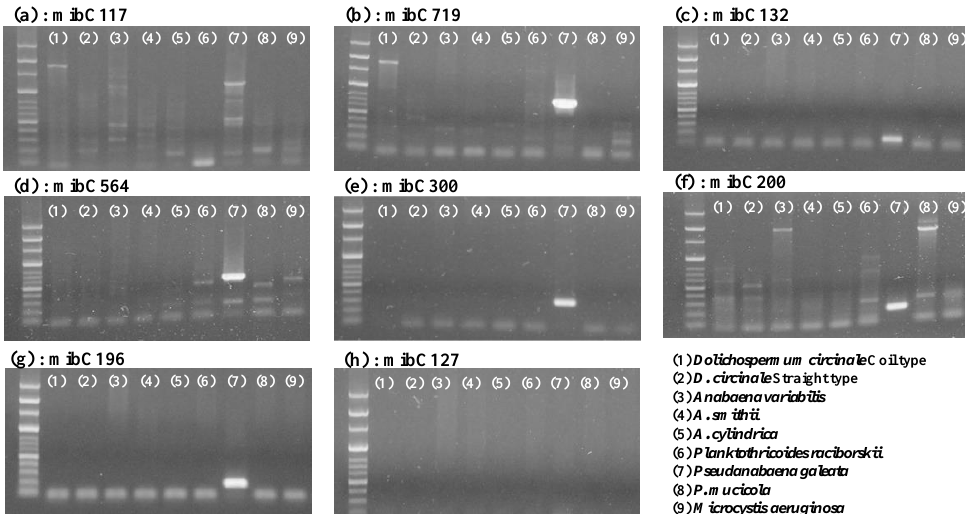
Figure 2. Amplification of the 2-MIB-synthesizing gene, mibC , by eight sets of primers using the genomic DNA of cyanobacteria strains cultured in the laboratory as templates. The PCR product generated by each primer set was analyzed by agarose gel electrophoresis. The electrophoresis gel shows the amplicons produced by PCR with ( a ) mibC117, ( b ) mibC719, ( c ) mibC132, ( d ) mibC564, ( e ) mibC300, ( f ) mibC200, ( g ) mibC196, and ( h ) mibC127. mibC127 did not produce amplicons.